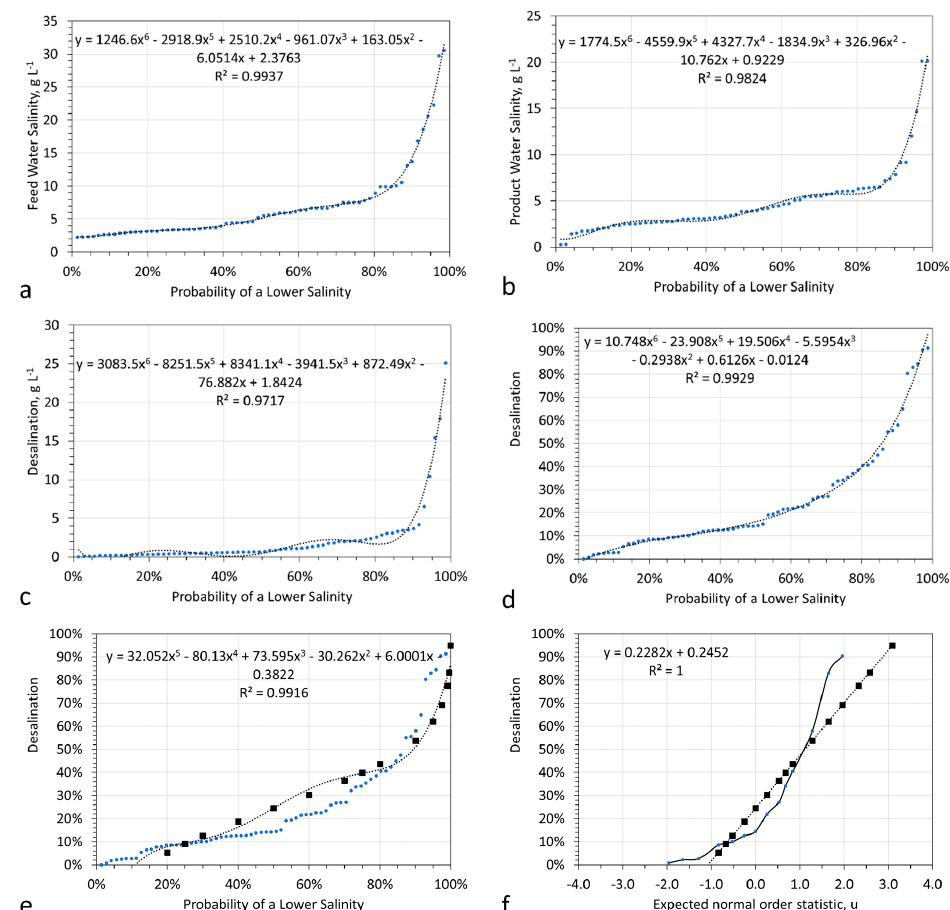
Figure 15. Probability distributions. ( a ) Feed water; ( b ) product water; ( c ) desalination, g L − 1 ; ( d ) desalination (%). ( e ) Observed desalination distribution for individual water batches and the normal order distribution (square data points) resulting from the aggregation of 70 water batches to create a desalinated water product. ( f ) Desalination distribution for individual water batches (circles) and the aggregation of 70 water batches (squares) plotted against the expected normal order statistic, u. Dataset. Appendix B Table A1. Mean desalination = 24.5%; standard deviation = 22.8%; minimum = 0%; 1st quartile = 9.2%; median = 14.3%; 3rd quartile = 33.9%; maximum = 91%. The methodology